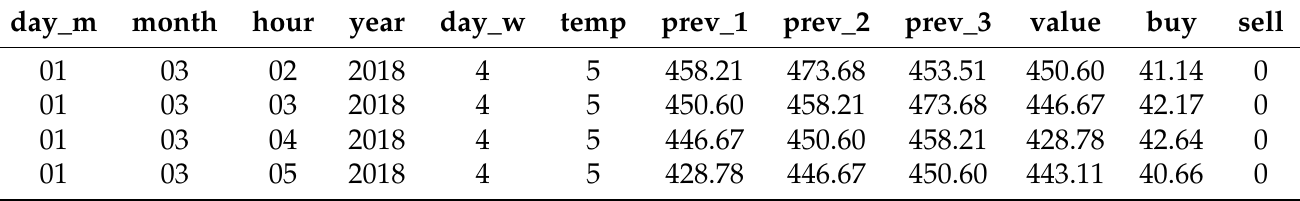
Table 2. Participant’s file